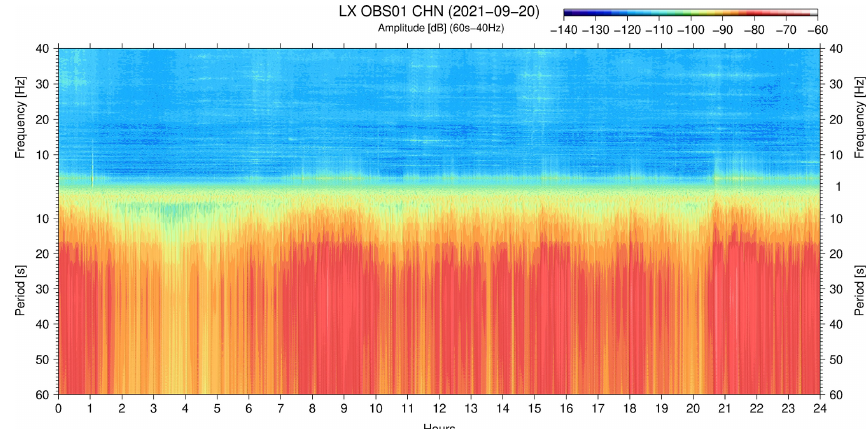
Figure 11. LX OBS01 spectrogram – on this particular day, a strong current flow scenario was observed during the campaign without harmonic tremors with noise around the natural frequency of OBS–sediment coupling resonance. The tilt noise, resulting from the current flow impact on the OBS structure, was observed almost during the entire